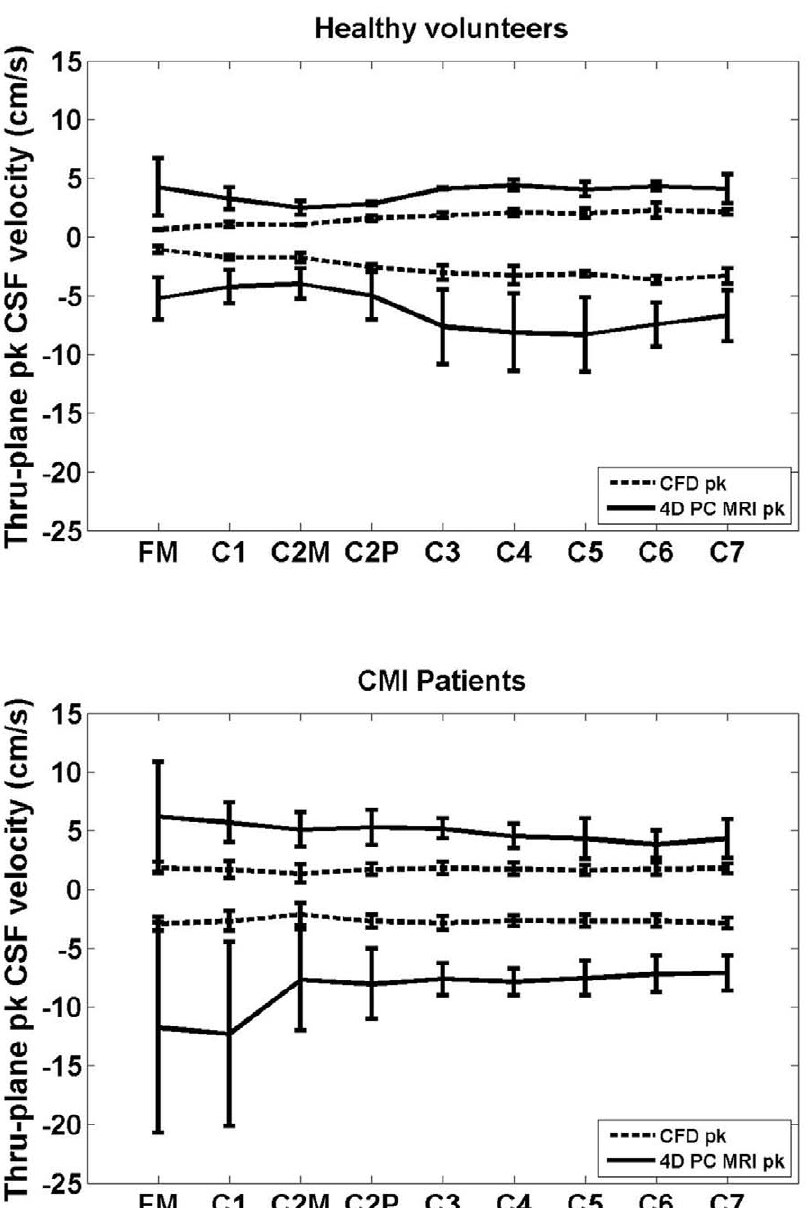
Figure 4. Comparison of the mean thru-plane peak CSF velocities between 4D PC MRI and CFD. Peak systolic and diastolic velocities were measured by the 4D PC MRI and simulated by CFD in the cervical spine (FM-C7, FM is near the head and C7 is towards the feet) in healthy volunteers (Healthy a, b and c) and CM patients (CM 1, 2, 3, and 4). Values are given as mean 6 SD (cm/s) for the three healthy subjects (top) and four CM patients (bottom). Positive (diastolic) and negative (systolic) velocities reflect head and foot directed flow,